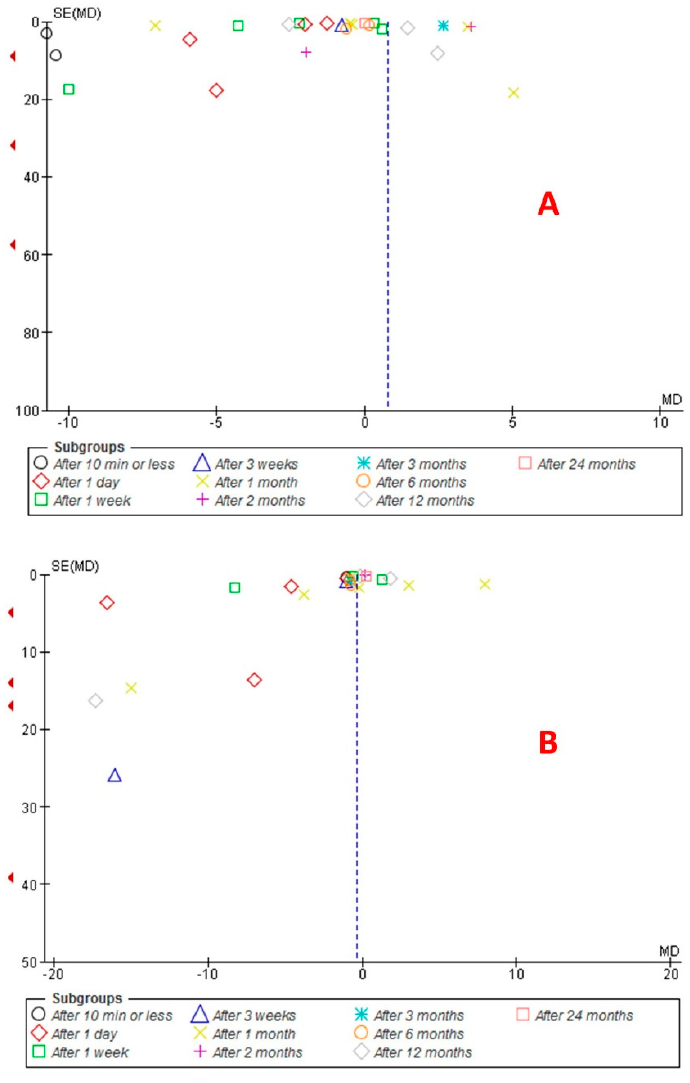
Figure 7. Funnel plot of the random effect of ( A ) salivary nickel levels and ( B ) salivary chromium levels in patients under fixed orthodontic treatment (before versus after treatment).